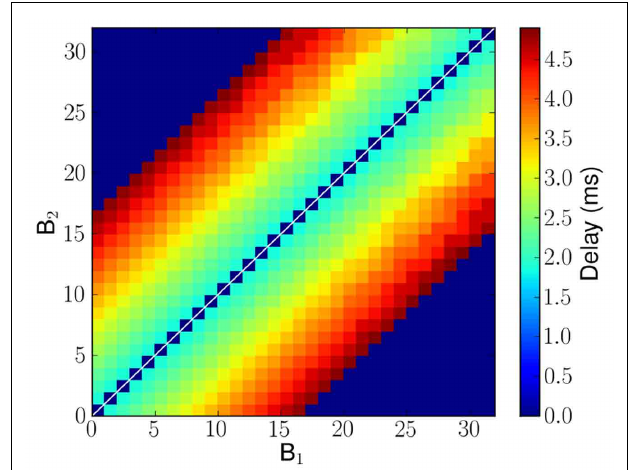
FIGURE 4 | Implemented delayed projections from B 1 to B 2 neurons in millisecond. In case of no connection, it is marked as having 0ms delay and is shown in blue.The delays were chosen from the ones available in the hardware implementation and so minor deviations from a pure linear profile can be observed.